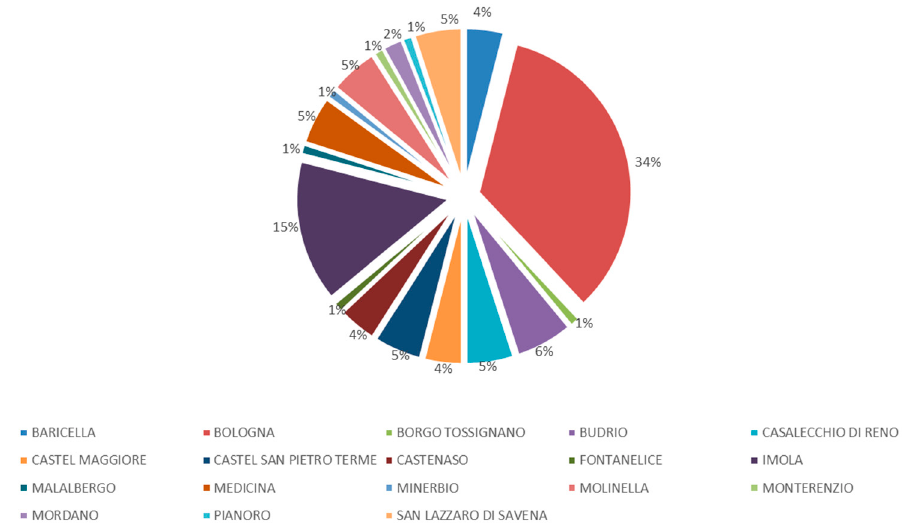
Figure 4. Used cooking oil (UCO) collected in the selected municipalities (as the percent of the total) in the 2013–2014 biennium.